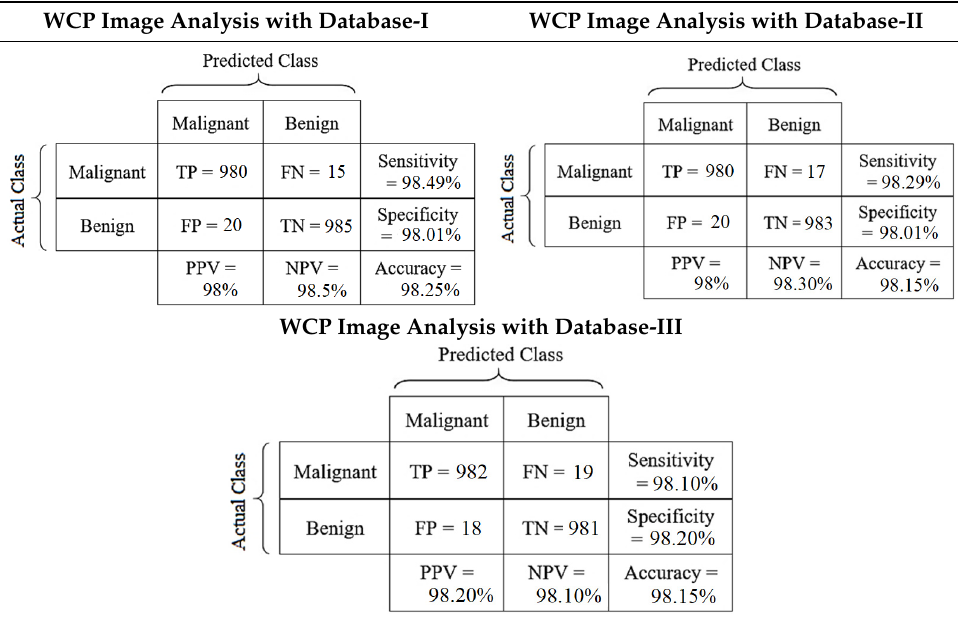
Table 7. The confusion matrices of 10-fold cross-validation result of three databases by WCP image-based CNN Network with KNN classifier.